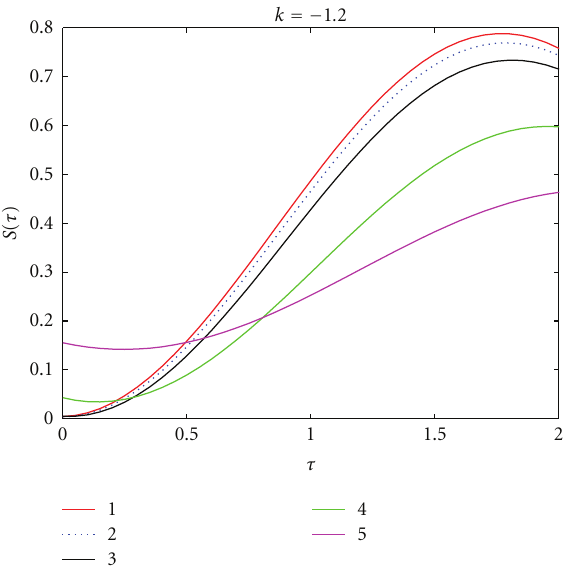
Figure 10: The relationship of similarity function S ( τ ) and τ under k = − 10 .